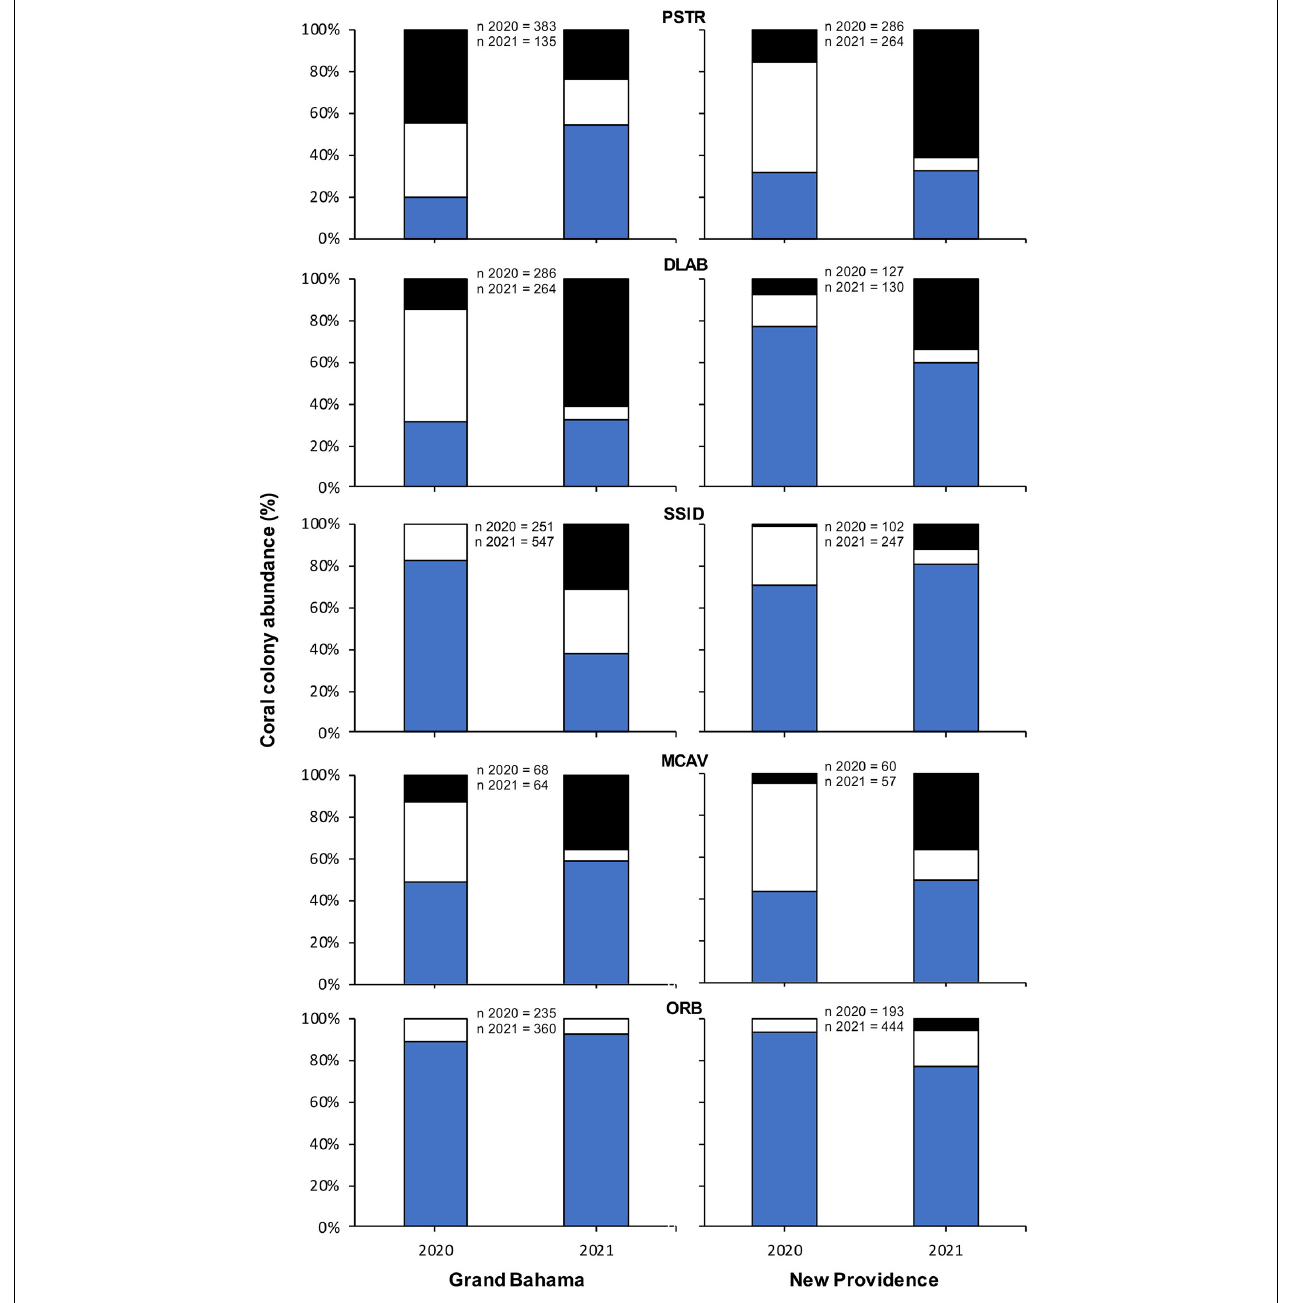
FIGURE 5 | Change in percentage of all colonies of Pseudodiploria strigosa (PSTR), Diploria labyrinthiformis (DLAB), Siderastrea siderea (SSID), Montastraea cavernosa (MCAV), and Orbicella spp. (ORB) observed that were healthy (H, blue), infected with SCTLD (white), and recent mortality (RM, black) for sites off Grand Bahama and New Providence surveyed for SCTLD in 2020 and